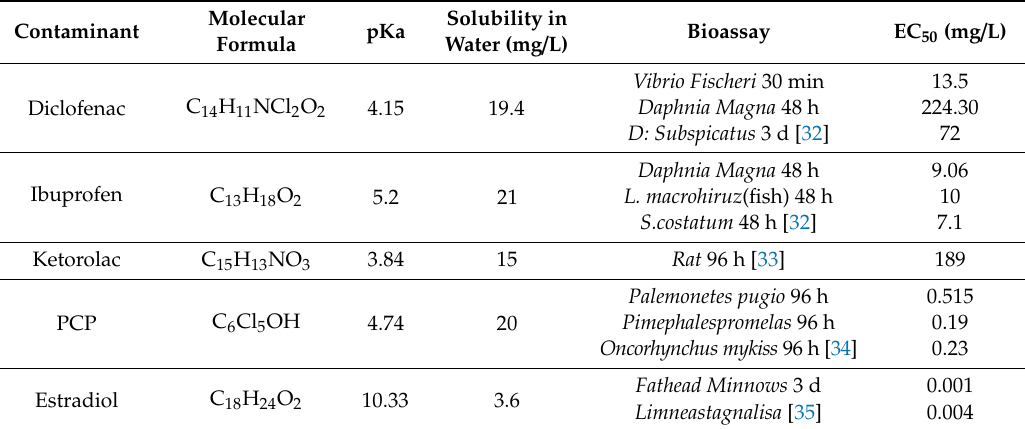
Table 1. Pharmacokinetic characteristics of contaminants.